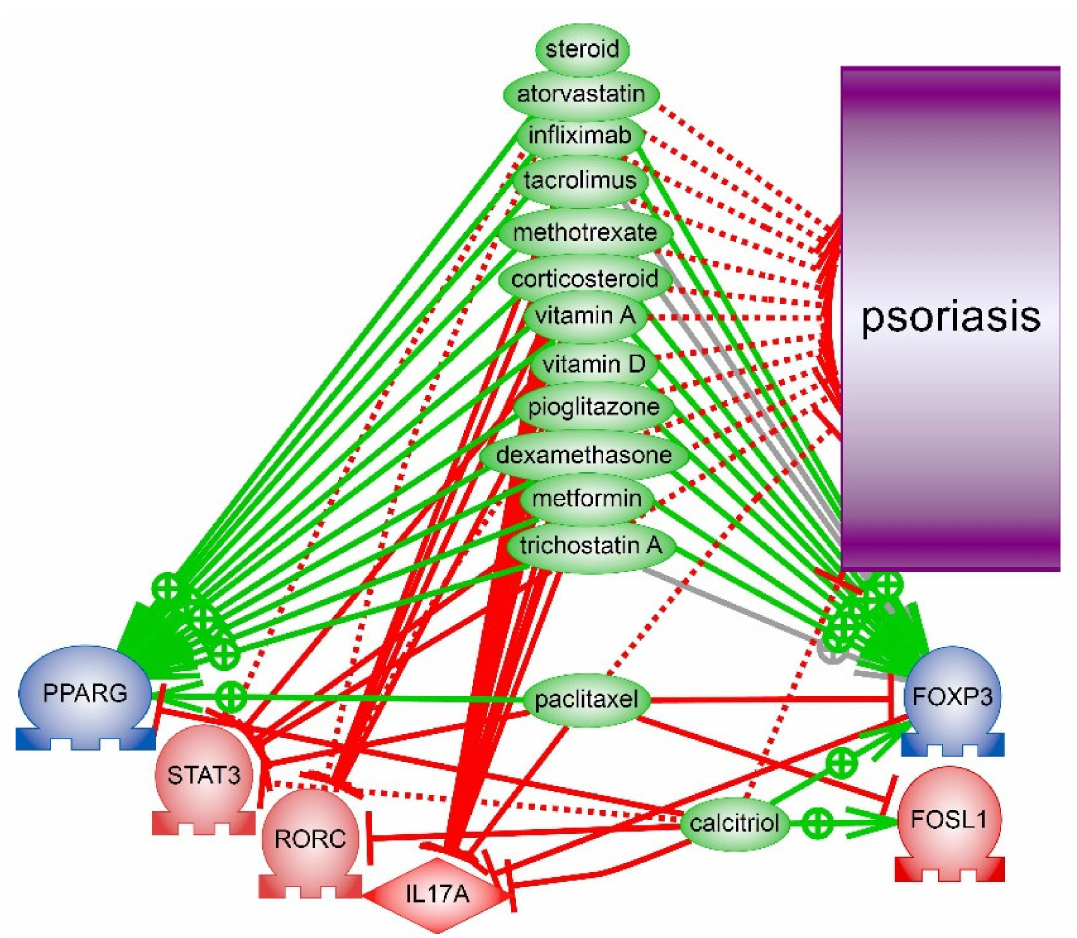
Figure 9. Anti-psoriatic drugs that may stabilize PPAR γ signaling and supress IL17 expression. Calcitriol and paclitaxel however have been reported to inhibit PPAR γ or FOXP3 . See details of interactions and references in files with models in Supplemental